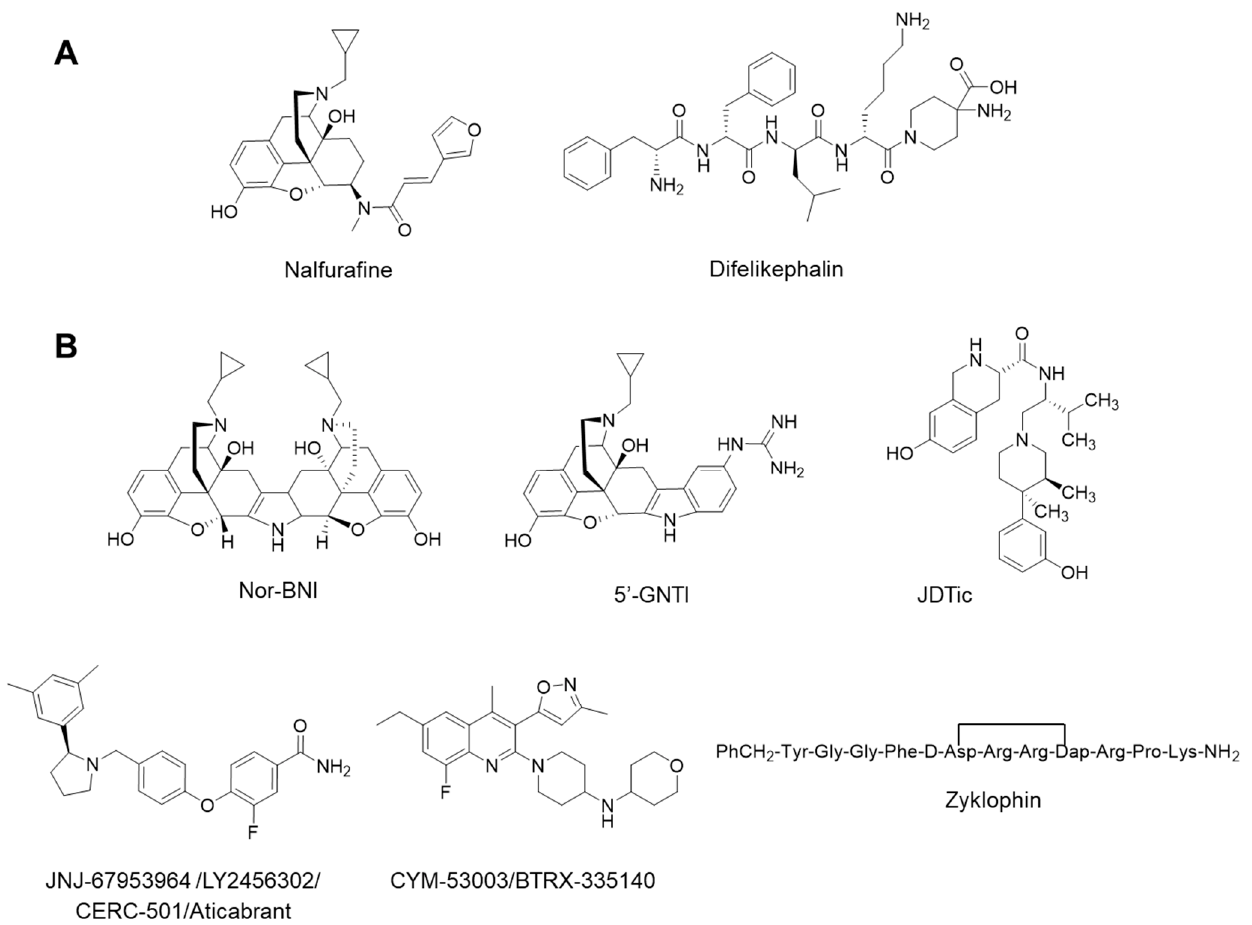
Figure 1. Representative selective KOR ligands used in the clinics, as potential therapeutics or research tools. ( A ) KOR agonists; ( B , top ) long-acting KOR antagonists; ( B , bottom ) short-acting KOR antagonists. KOR